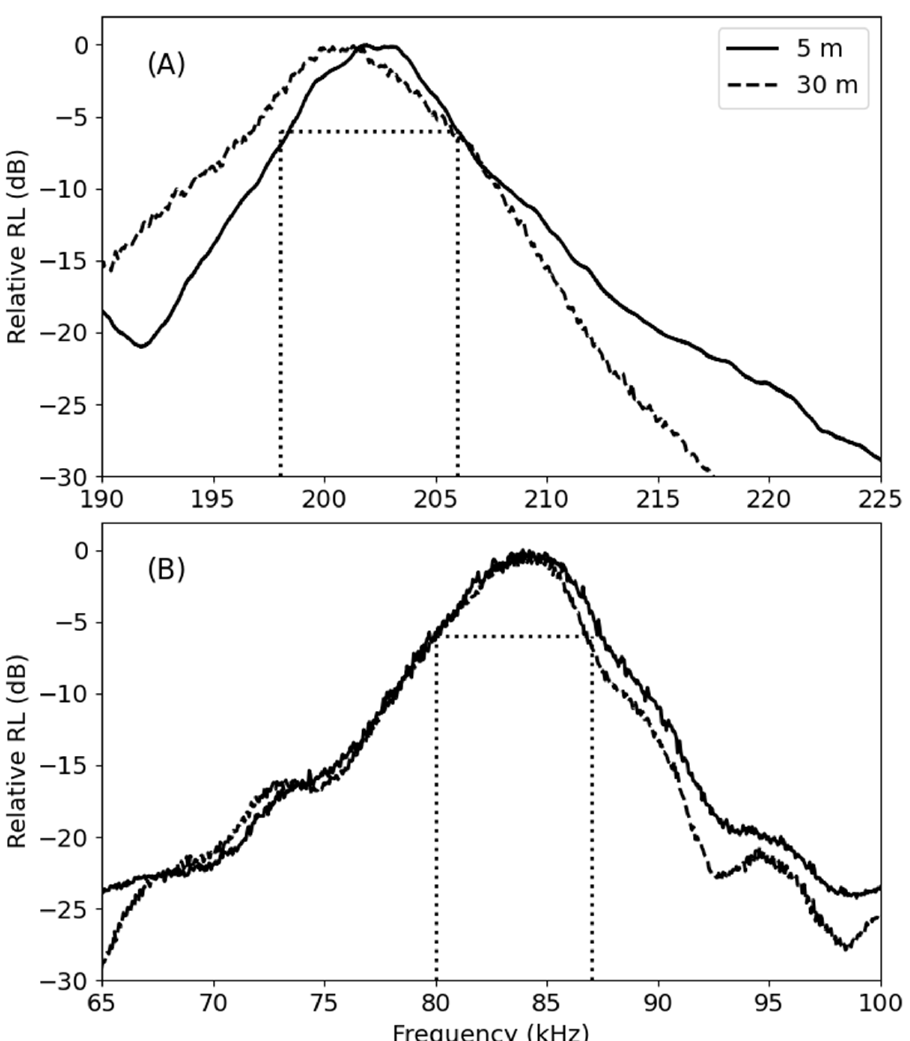
Figure 4. The relative received levels (RLs, in decibels (dB)) of the signals of the acoustic frequency bandwidth of the dual-frequency echosounder used in this study, as observed at two different depths. The dotted lines indicate the − 6 dB acoustic bandwidths of 198–206 ( A ) and 80–87 kHz ( B ). The peak frequencies of the two channels were found to be 201.5 ( A ) and 84 kHz ( B ).